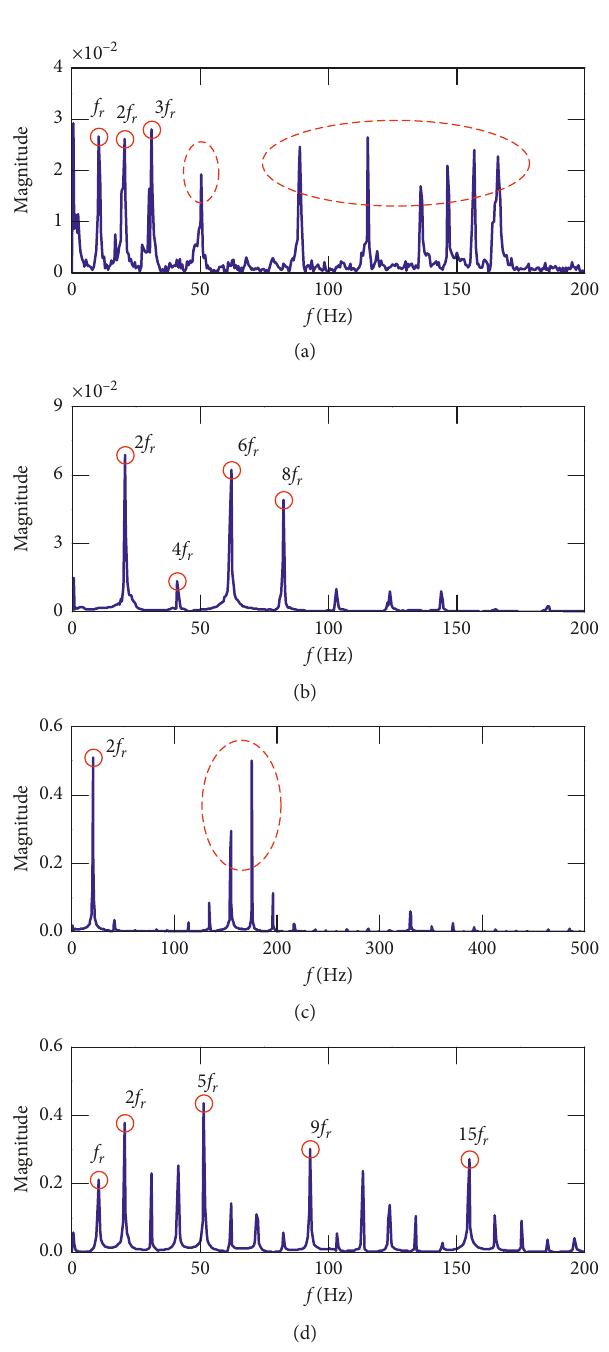
Figure 13: Results obtained by Hankel-SVD for a bearing outer race fault signal: (a–d) envelope spectra of IMF 1, IMF 2, IMF 3, and IMF